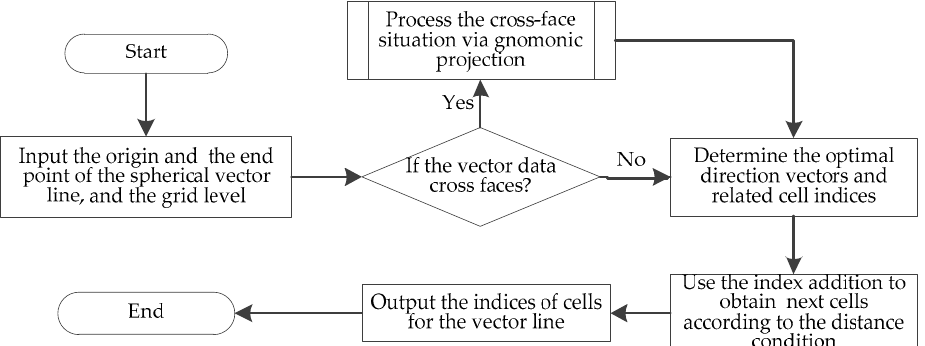
Figure 15. Flowchart of discretizing the vector line on the sphere using hexagonal grids: the process in this algorithm (except the index addition) is referred to the literature [35] (source—partly cited from [35] and changed according to own study).